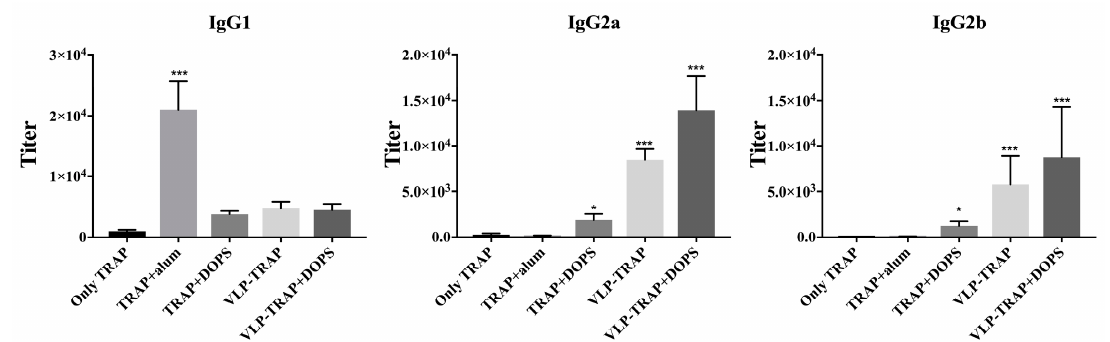
Figure 3. Assessment of IgG subtype in BALB/c mice. The antibody subclasses were tested on day 59 of the immunized mice. VLP-conjugate vaccines induced the more protective isotypes IgG2a and IgG2b compared to TRAP formulated in alum. In other hand, the group of mice vaccinated with TRAP + alum induced IgG1 subtype, as expected. Note: *** p -value < 0.0001; * p -value < 0.01.